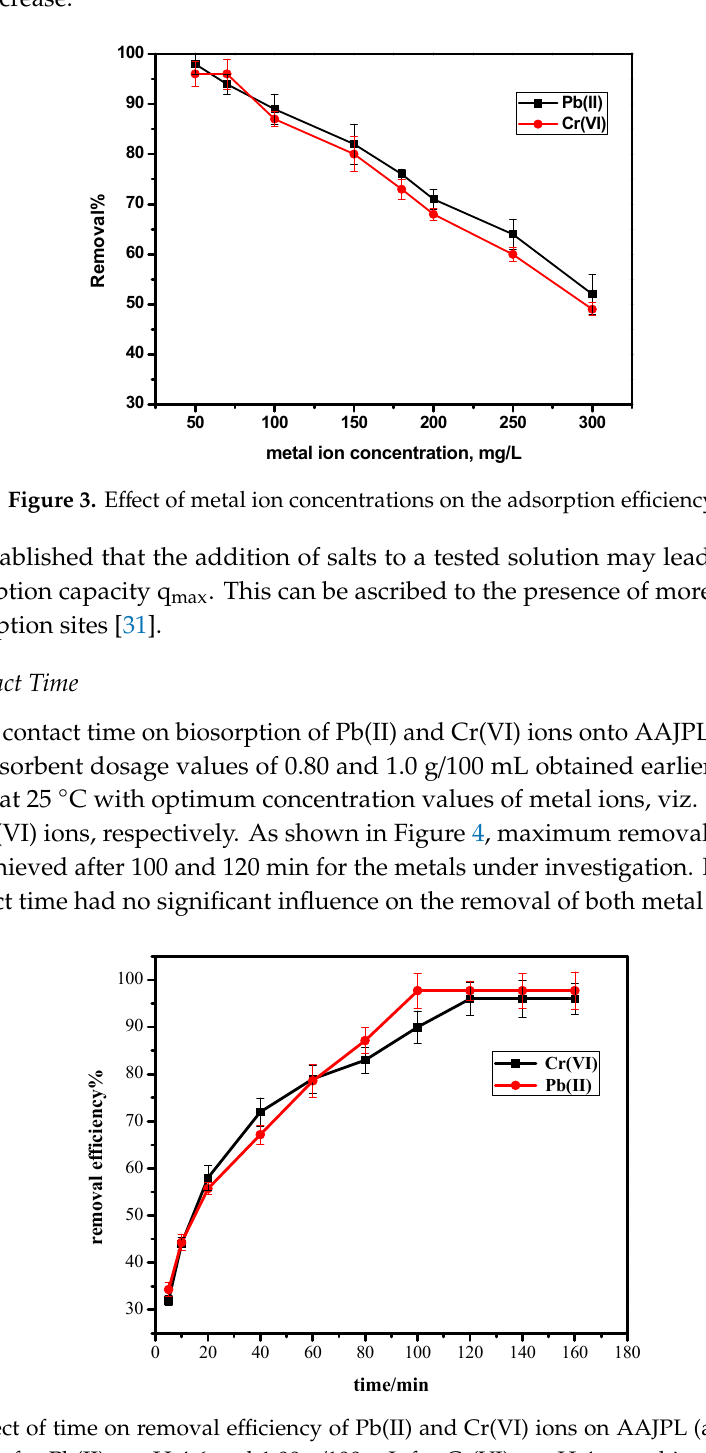
Figure 2. Effect of biosorbent mass on the removal efficiency of Pb(II) and Cr(VI) from aqueous solutions (metal ion concentrations: 50 mg/L for Pb(II) at pH 4.6 and 70 mg/L pH 4 for and Cr(VI); temperature: 25 °C).